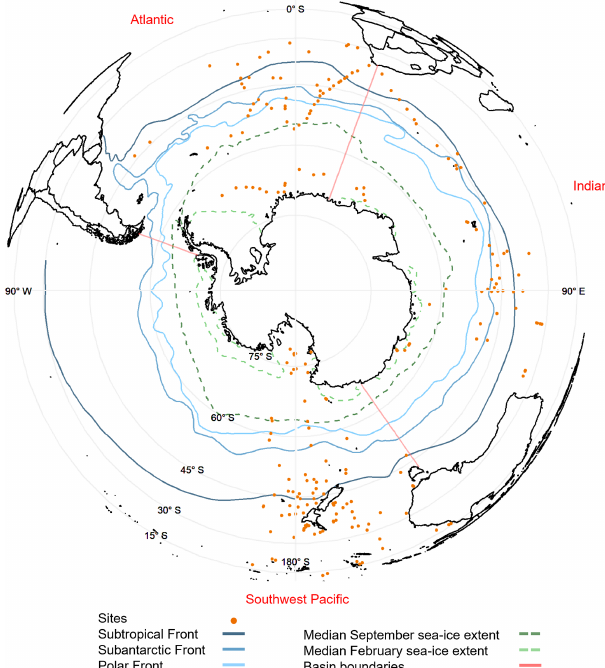
Figure 1. Surface sediment sites included in the SO-RAD database shown with (a) Southern Ocean frontal boundaries (Orsi et al., 1995) and ocean basin boundaries (WOCE Data Products Com- mittee, 2002) and (b) the 1981–2010 median sea-ice extent for February (dashed line) and September (solid line) (Fetterer et al.,